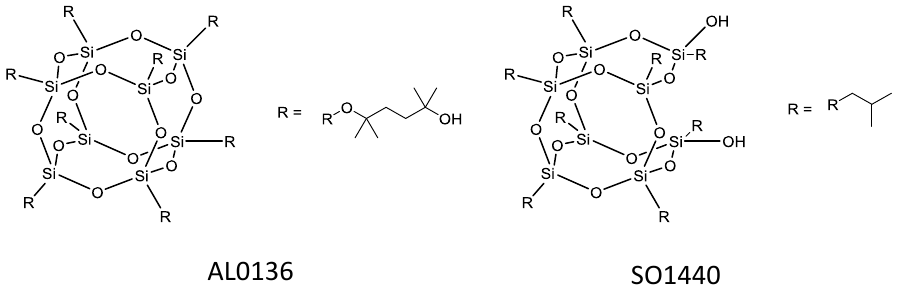
Figure 19. Structures of the POSSs incorporated into PEBAX as reported in [164].